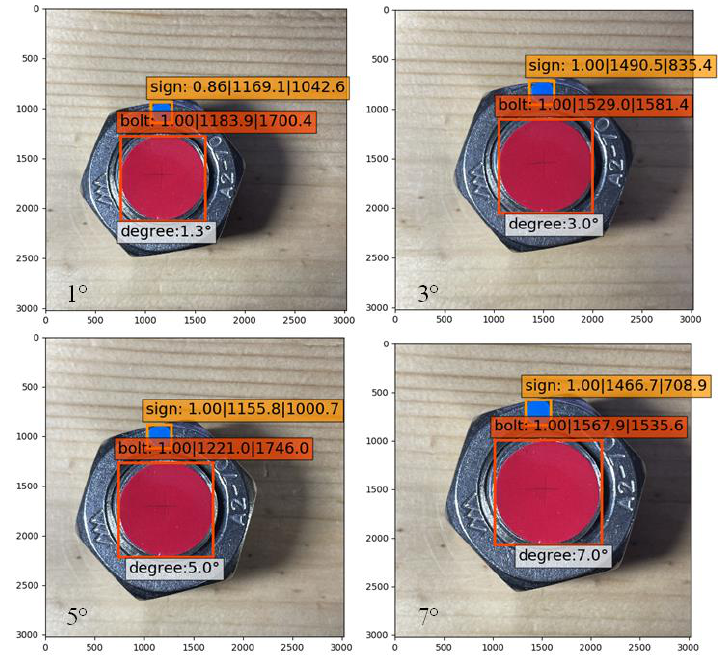
Figure 13. Best identification results at a tiny angle.